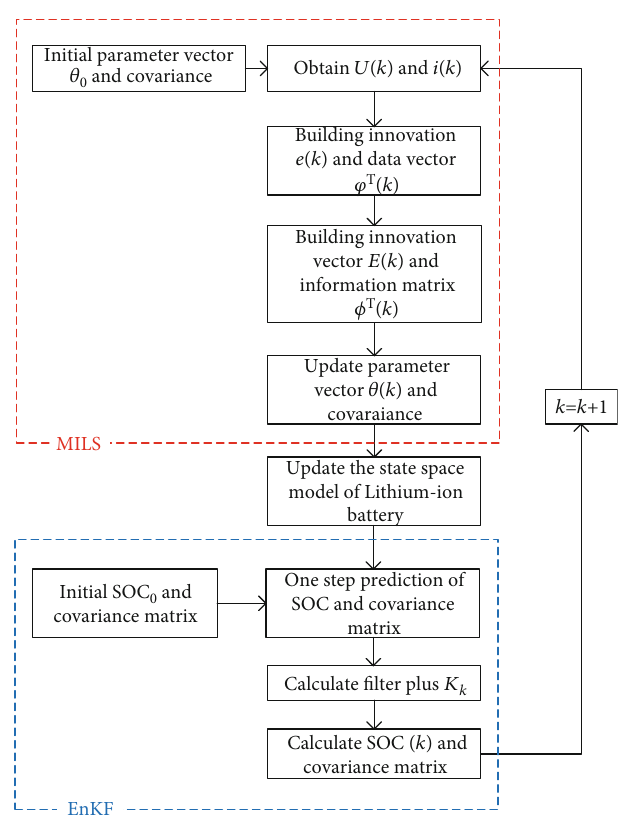
Figure 2: Integration strategy of MILS and